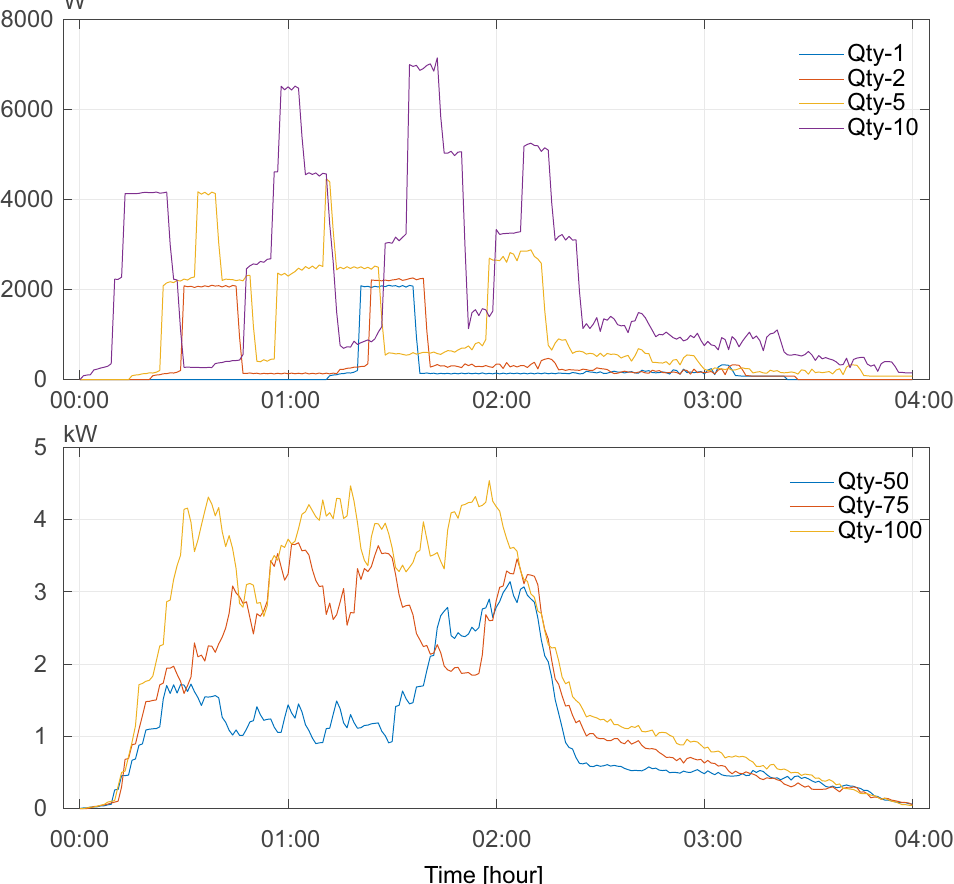
Figure 14. Load profile for different number of washing machines.